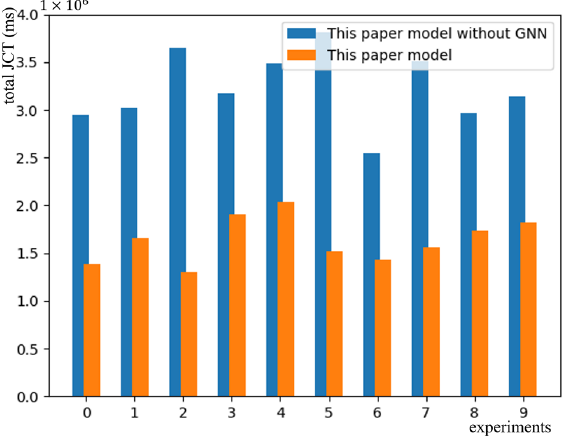
Figure 11. Impact of a GNN on